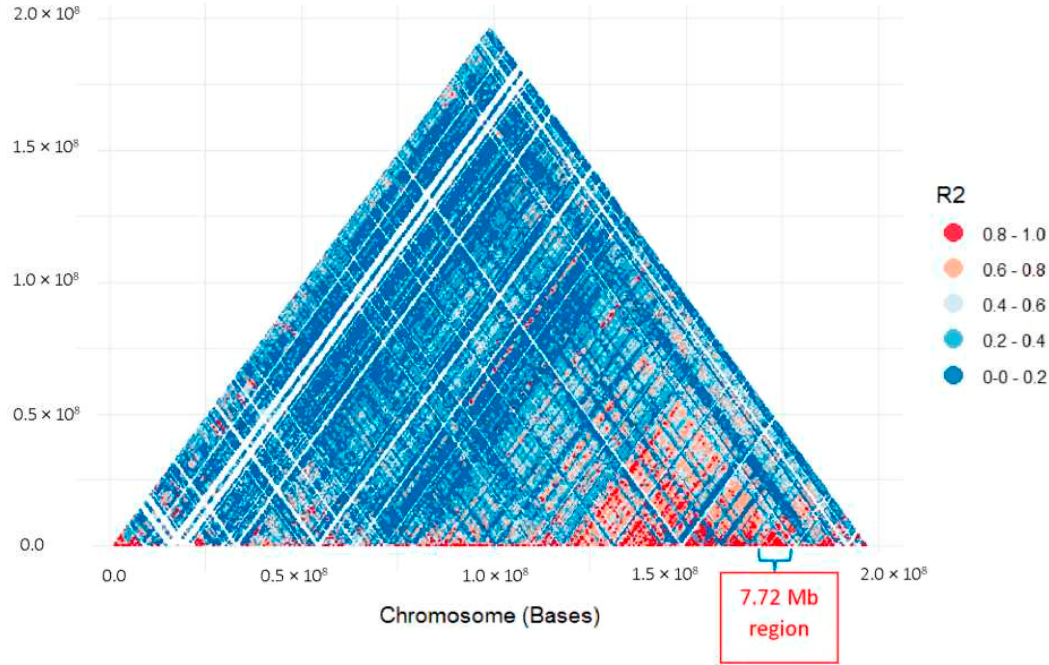
Figure 4. Pairwise Linkage Disequilibrium (LD) Plot of the LG13. Individual data points reflect squared allele frequency correlations (R2) for all possible pairs of polymorphic SNP markers of LG13. The x- and y-axes correspond to the coordinates within 13 LG. Location of 7.72 Mb indicated by curly bracket.